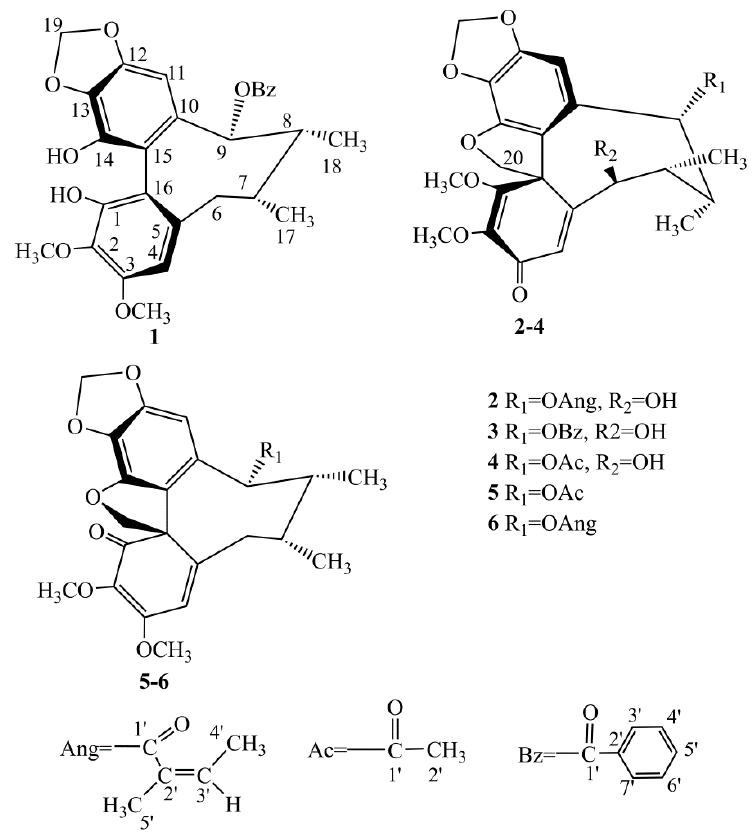
Figure 1. Structures of compounds 1 – 6.